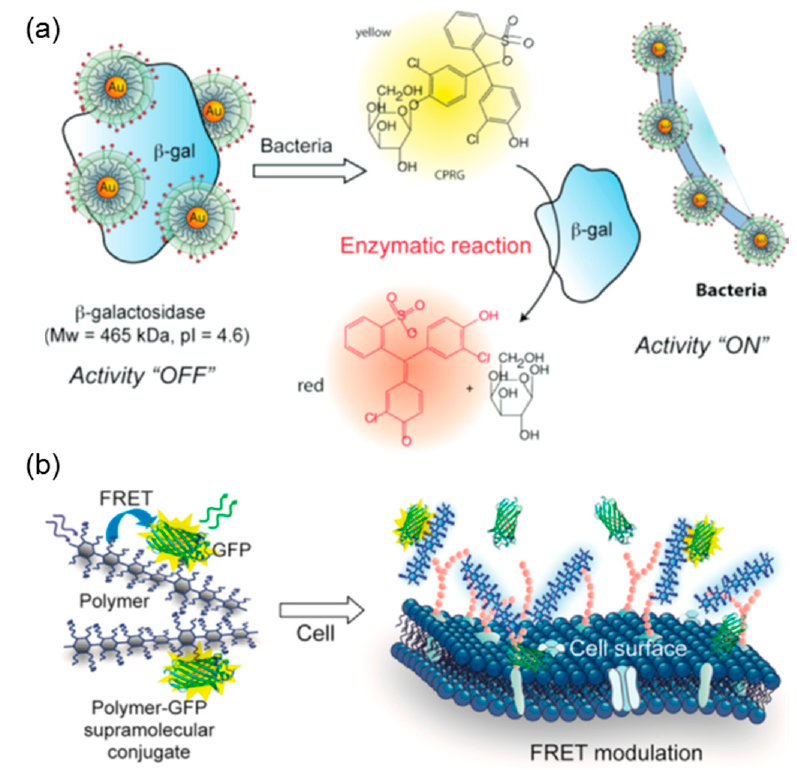
Figure 9. Schematic illustration of “chemical nose/tongue” sensing practice based on the electrostatically driven complexation of catalytic ( a ) and fluorescent ( b ) proteins. Figure 9 was taken from the works of [66,80].